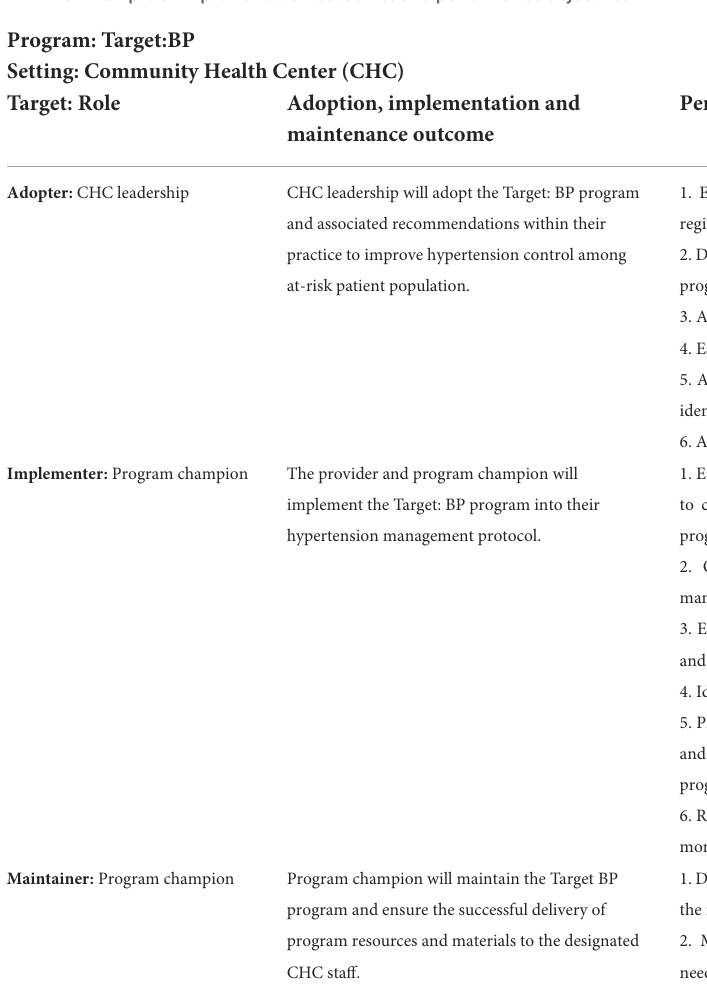
TABLE 3 Example of Implementation outcomes and performance